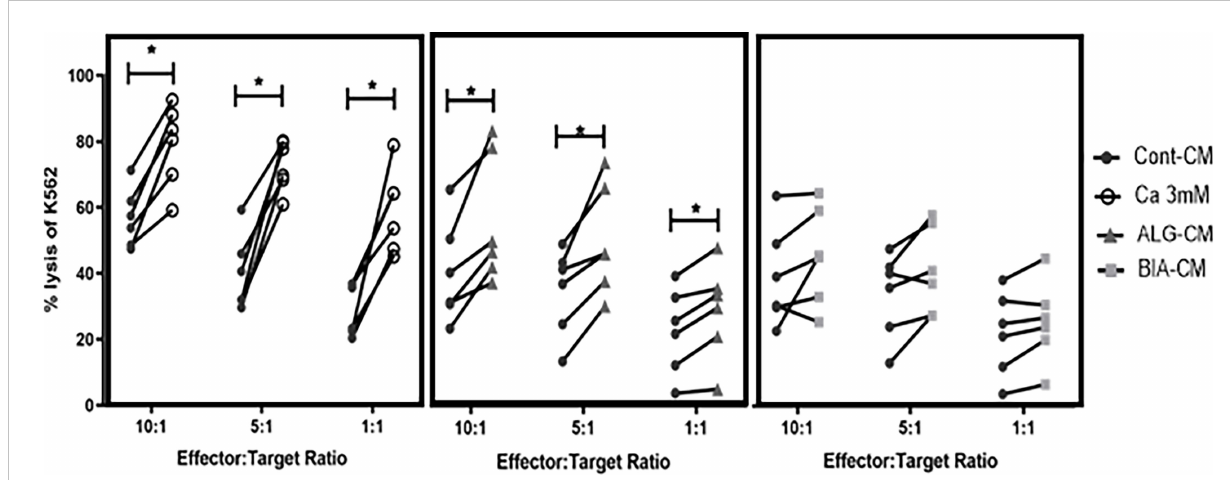
FIGURE 1 Cytotoxic activity of NK cells. The cytotoxic activity of NK cells was assessed by using puri fi ed NK cells from healthy donors as effector cells and K562 cell line as target cells at the indicated effector: target (NK: K562) ratios of 10:1, 5:1, and 1:1. NK cells were mixed with CFSE-labeled K562 for 18h before analysis of CFSE and 7-AAD double positive dead K562 cells by fl ow cytometry. Cells were incubated with a CaCl 2 solution at 3 mM (white circle, left side), conditioned medium from either calcium alginate dressing ALG-CM (grey triangle, middle) or BIA-CM (light grey square, right side) versus control medium (dark circle). Each line links data obtained from the same donor (n=6); Respective control cytotoxic activity at each ratio was used for statistical comparison using Wilcoxon paired test. * p